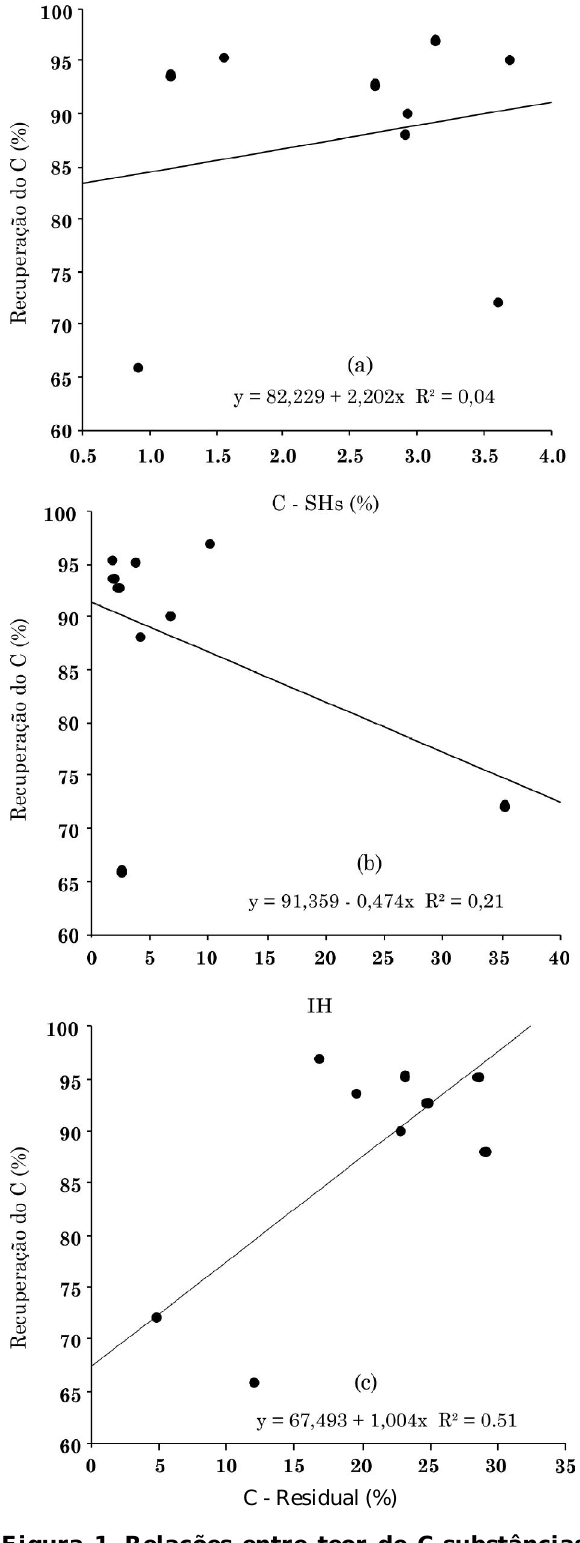
Figura 1. Relações entre teor de C-substâncias húmicas (C-SHs = C-fração ácido húmico + C- fração ácido fúlvico), índice de humificação (IH) e C-residual com a recuperação do carbono (CO/ CT x 100), em resíduos orgânicos